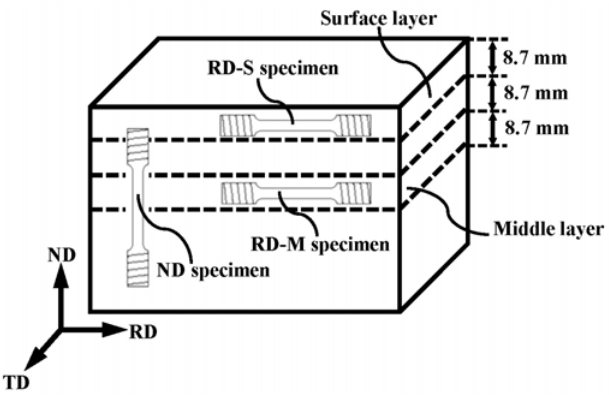
Figure 1. Sampling methods of mechanical tensile specimens.